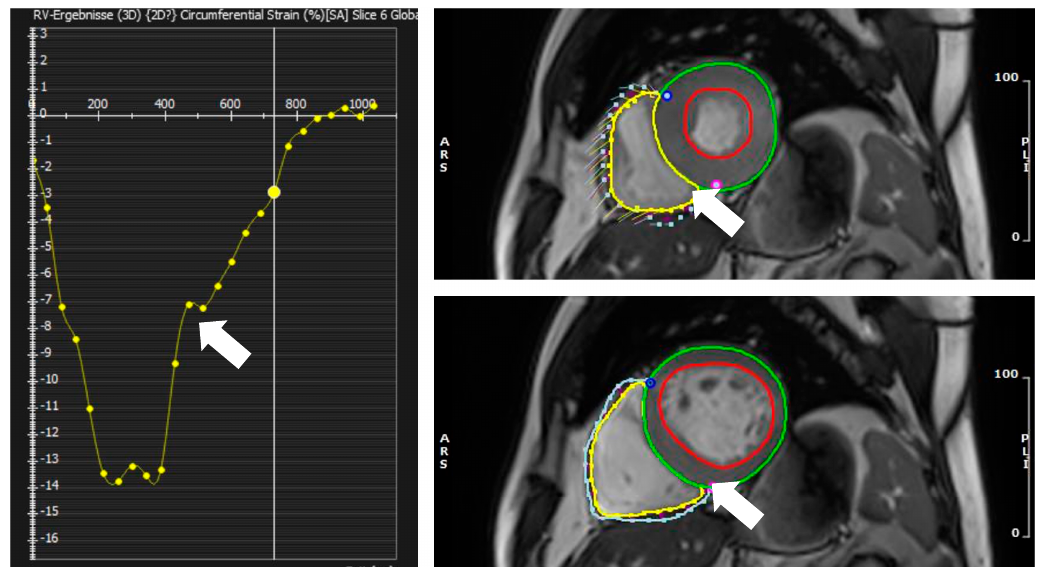
Figure 2. ( Left panel ) shows global circumferential strain GCS with the strain curve over the cardiac cycle (white arrow). ( Right upper panel )—needles show the movement of features in systole (white arrow); ( Right lower panel ) user defined diastolic contours of the RV from which features are extracted (white